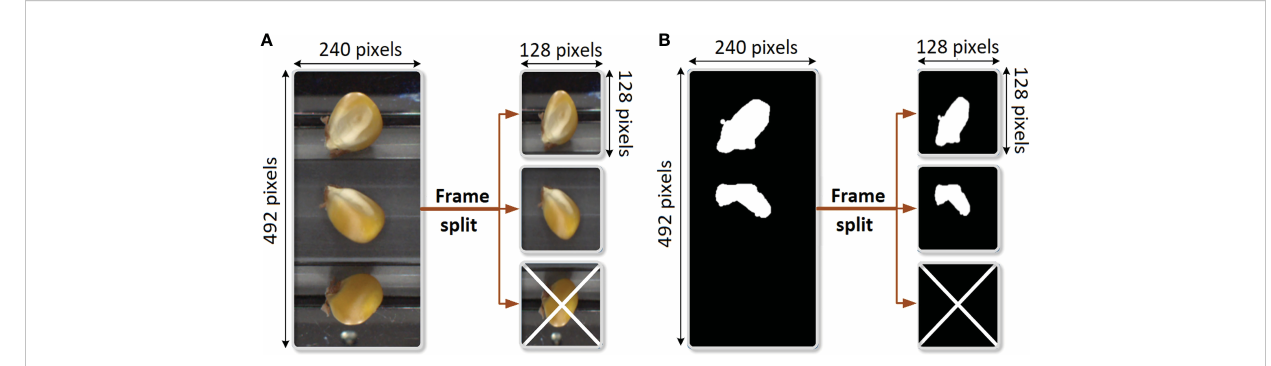
FIGURE 3 Preprocessing for segmentation consists of splitting each dataset image into three 128 x 128 images. Completely negative masks were excluded. (A) Preprocessing of RGB image. (B) Preprocessing of the